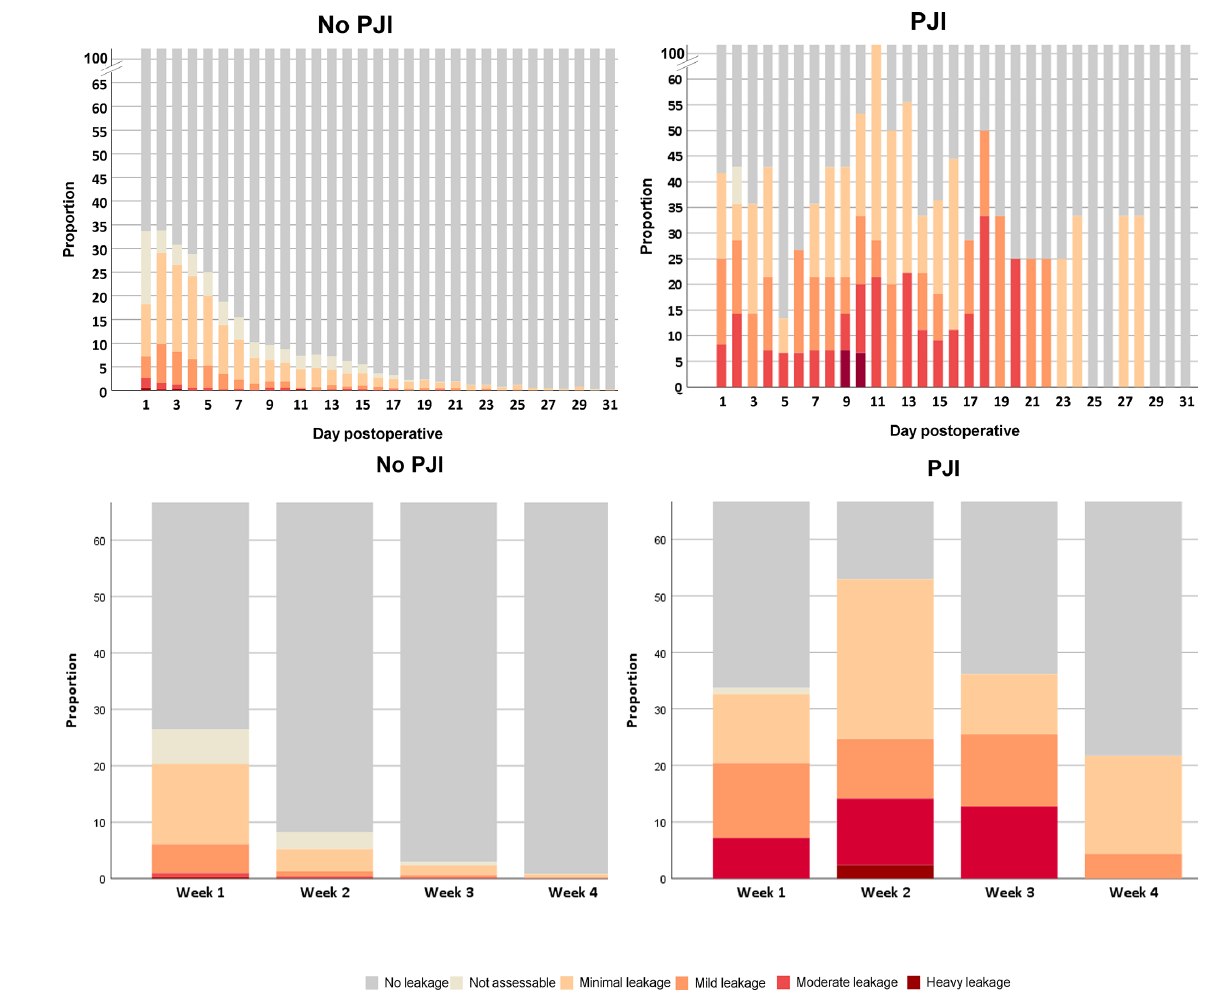
Figure 2. Reported extent and duration of postoperative wound drainage in patients with and without